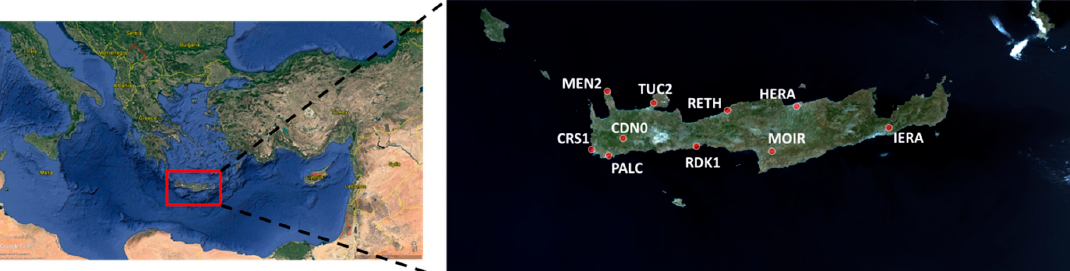
Figure 1. The permanent network of continuously operating GNSS reference stations on the island of Crete, Greece in the centre of eastern Mediterranean ( left ). The CDN0, CRS1, MEN2, RDK1, and TUC2 GNSS sites are operated by the Technical University of Crete. The remaining GNSS reference stations are part of a private HxGN SmartNet RTK network of METRICA S.A. The Sentinel-3A OLC_2_LFR image captured on 7 May 2016 has been used as background in the right image of the network.